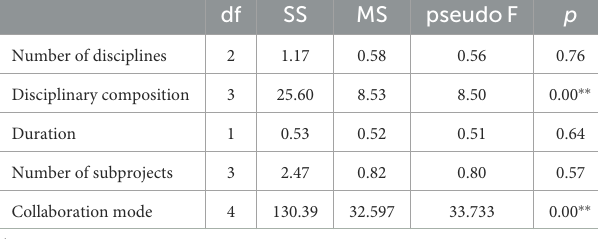
TABLE 3 PERMANOVA over Euclidean distances based on seven problems for 18 groups of the variables number of disciplines involved, duration, number of subprojects, collaboration mode, and disciplinary composition.